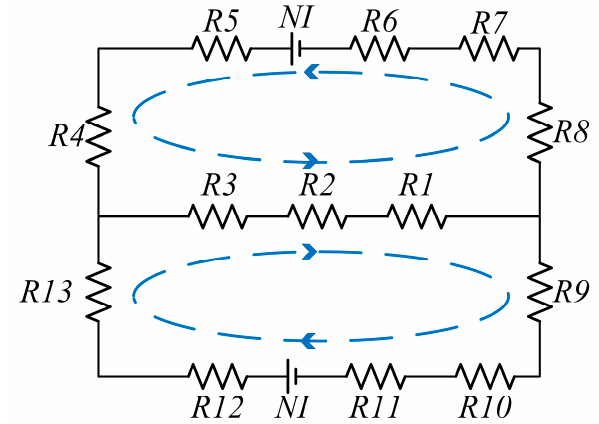
Figure 8. Axial multi-coil configuration equivalent magnetic circuit model.